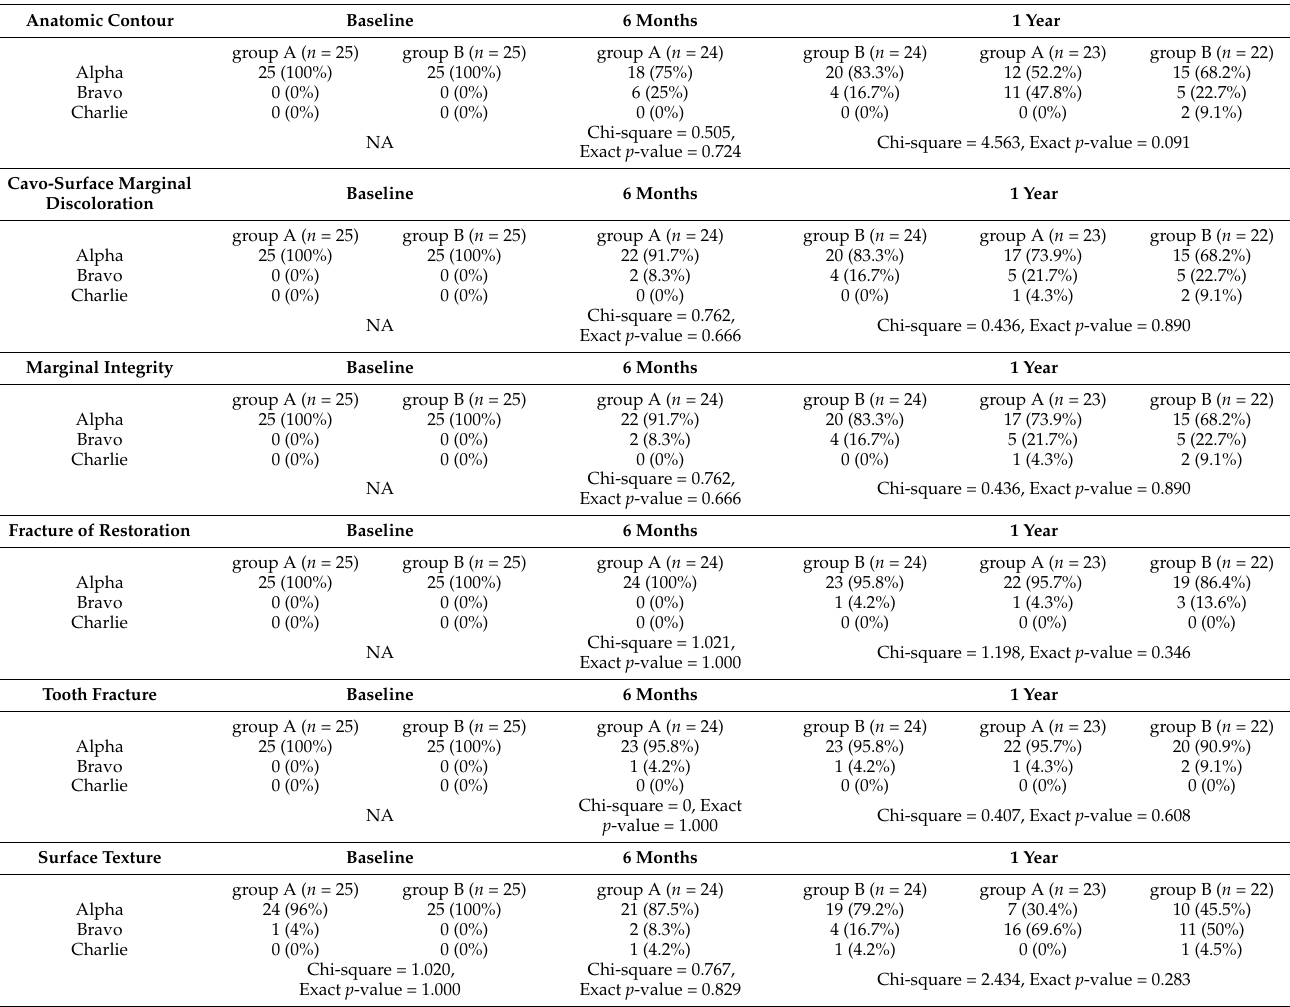
Table 3. Results of individual USPHS